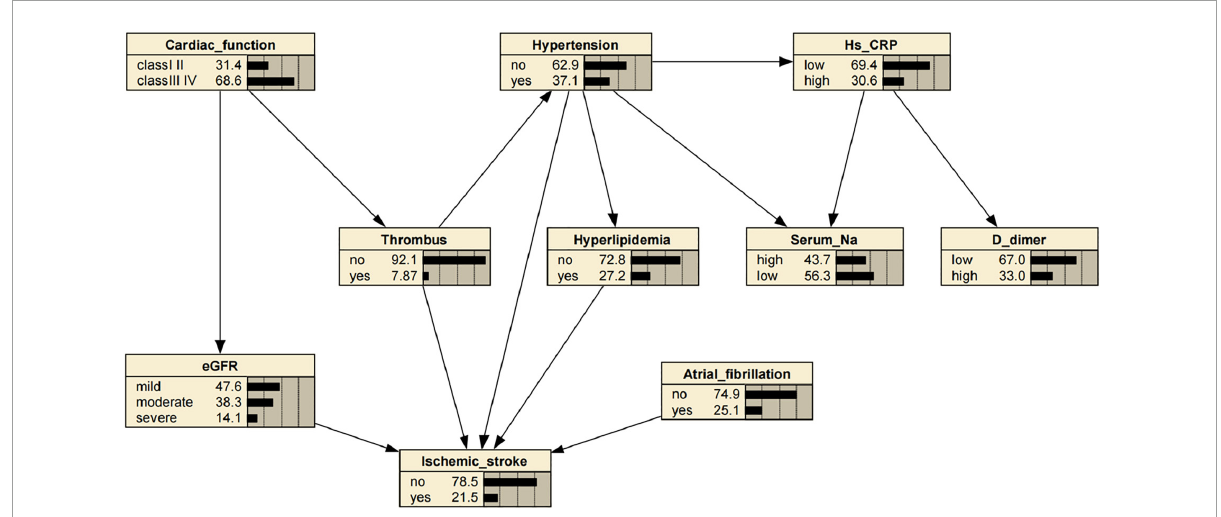
FIGURE2 Bayesian network (BN) for predicting occurrence of ischemic stroke (IS) in patients with dilated cardiomyopathy (DCM). The BN model used nine variables selected by univariate logistic regression analysis. Estimated glomerular filtration rate (eGFR), high-sensitivity C-reactive protein (Hs–CRP), Serum sodium [Na], and D-dimer levels were defined according to their values. eGFR ml/min/1.73 m 2 : mild ( ≥ 90), moderate (60–90), severe ( ≤ 60). Hs-CRP levels (mg/L): low ( < 5), high ( ≥ 5). Serum sodium [Na] levels (mmol/L): high ( ≥ 140), low ( < 140). D-dimer levels (ng/ml): low ( < 240), high ( ≥